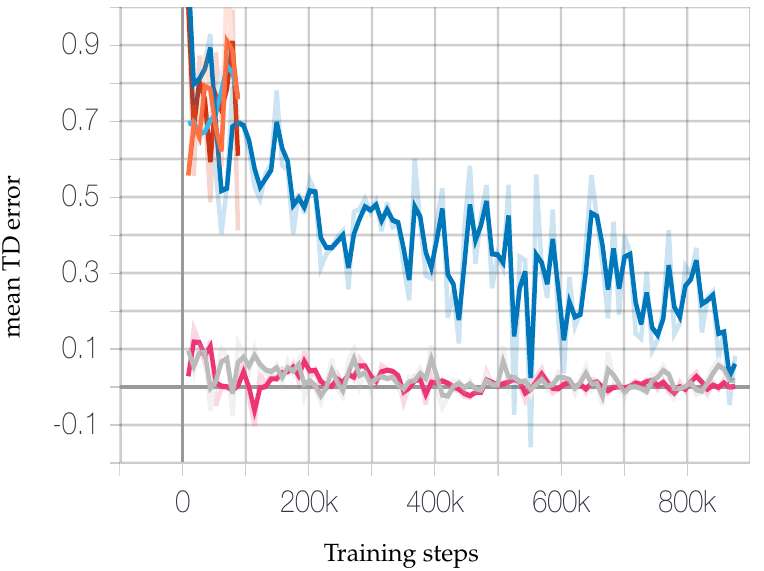
Figure 6. Asynchyperband successive halving approach to stop underperforming jobs early (random configurations).